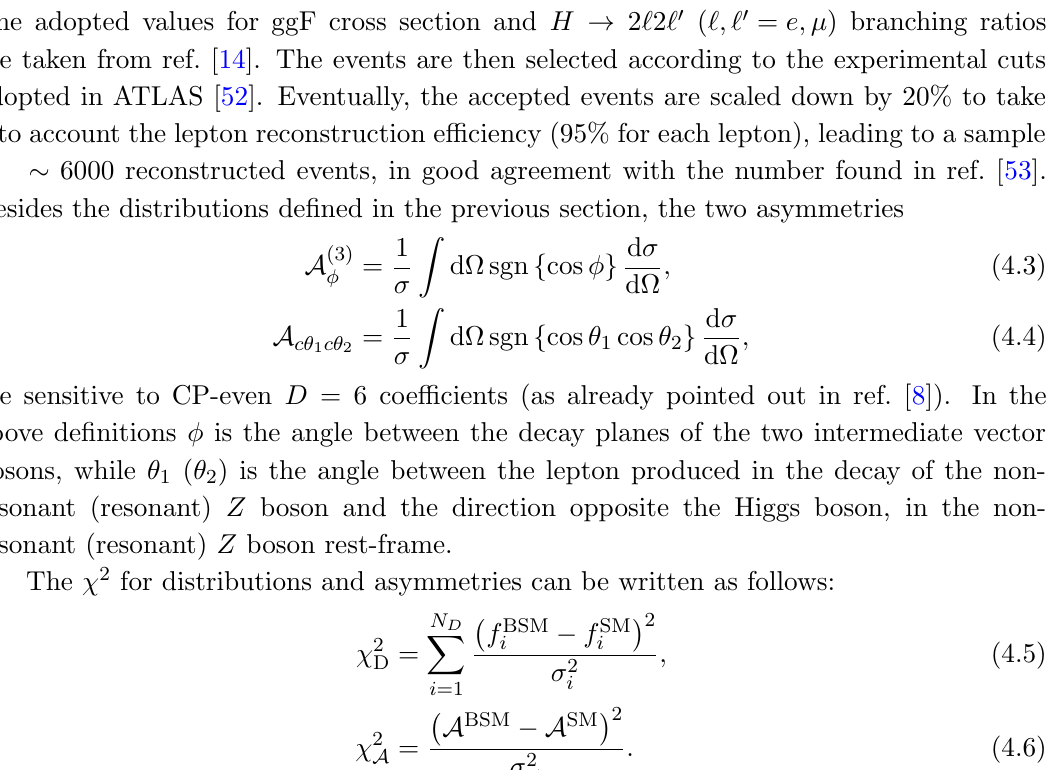
Figure 5. Upper panels: normalized distributions for (cid:30) at LO (black curve), at NLOPS EW ac- curacy (violet curve) and for values of ~ c Z(cid:13) = +1 (red curves), ~ c Z(cid:13) = ratios, according to the de(cid:12)nitions in eq. (4.2). Solid lines refer to pure 1 = (cid:3) 2 e(cid:11)ects, for dashed lines quadratic contributions are also included. The shaded bands between solid and dashed lines highlight the shape variations induced by the inclusion of quadratic